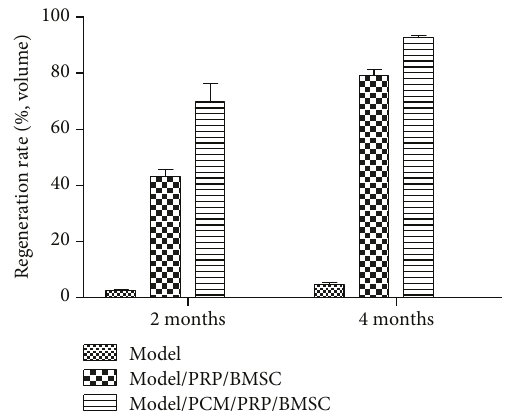
Figure 6: PCM/PRP/BMSC composites increase the rate of regenerated bone volume in rat tibia defect.